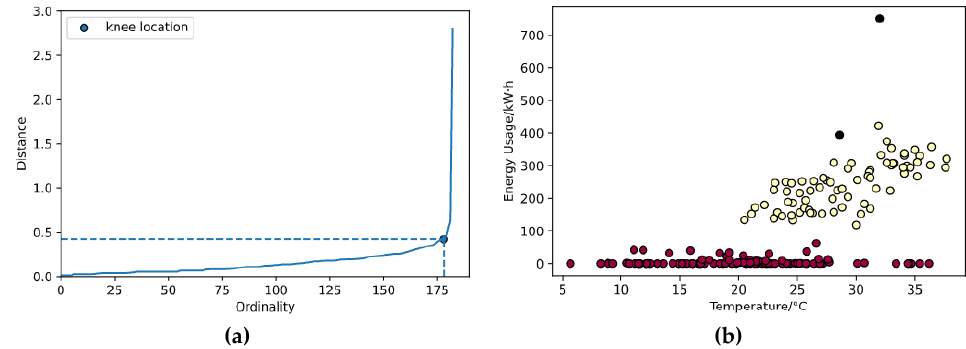
Figure 11. The knee locator and clustering result. (a) The knee locator; (b) The clustering result.